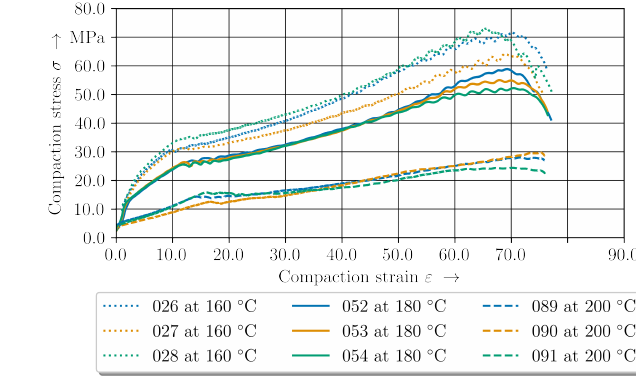
Figure 9. CT analysis of the initial material structure ( a ) cross-section in thickness direction of 1mm, 2mm and 4mm specimens ( b ) cross-section in fibre direction of the 2mm specimen ( c ) 3D view of the 2mm specimen.